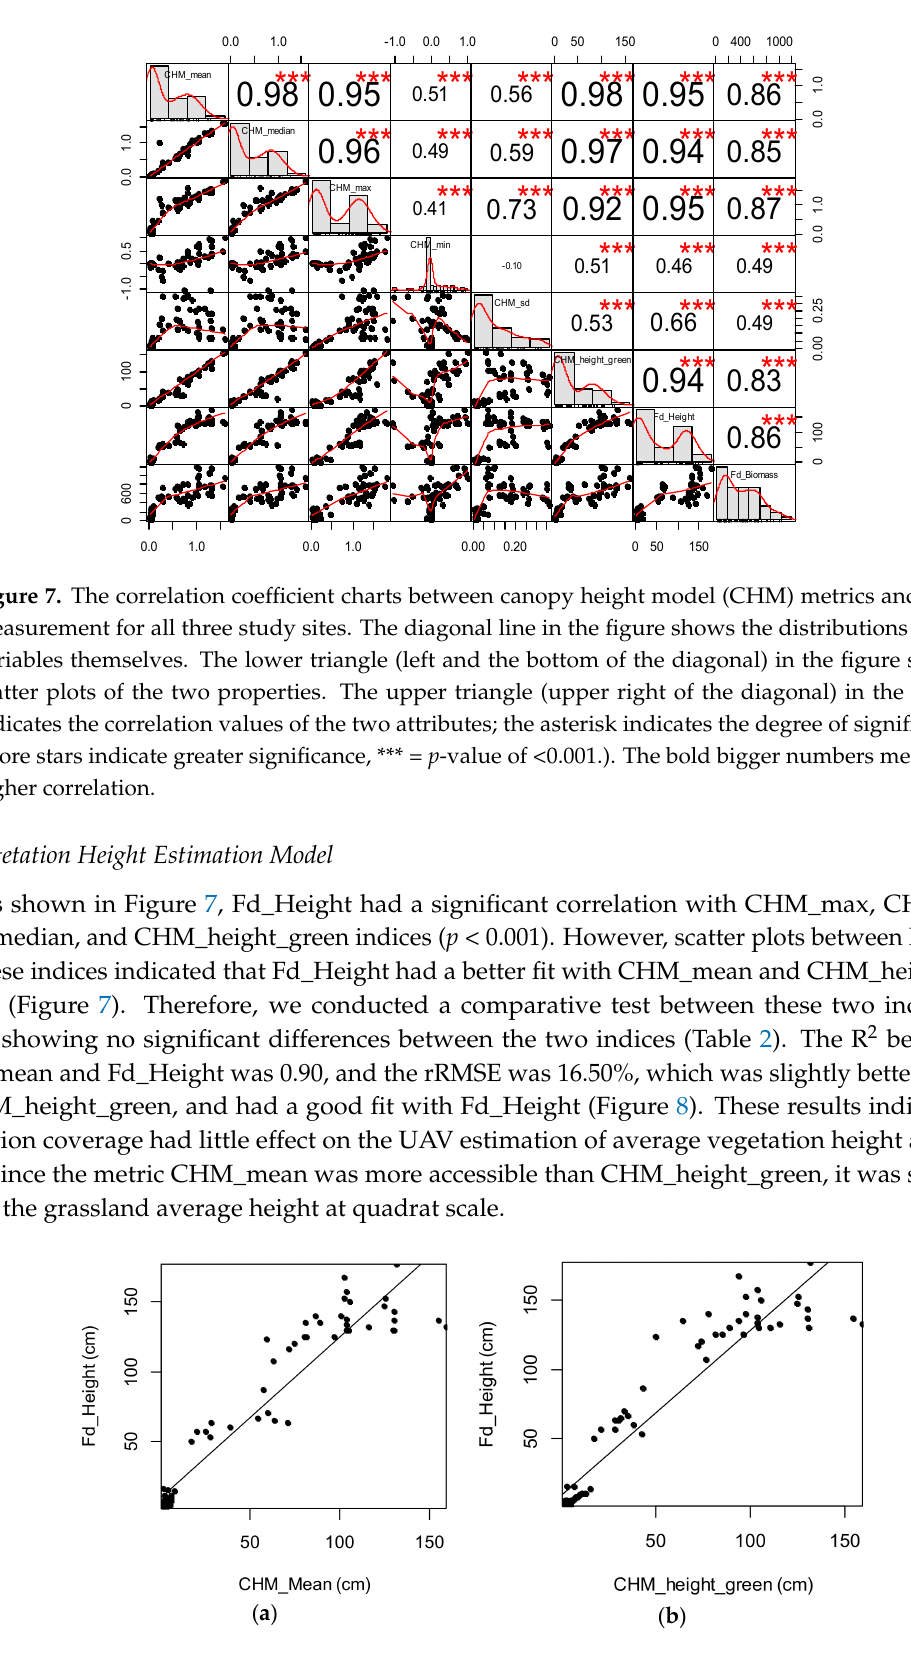
Figure 8. The scatter plot of Fd_Height and CHM_mean ( a ); and the scatter plot of Fd_Height and CHM_height_green ( b